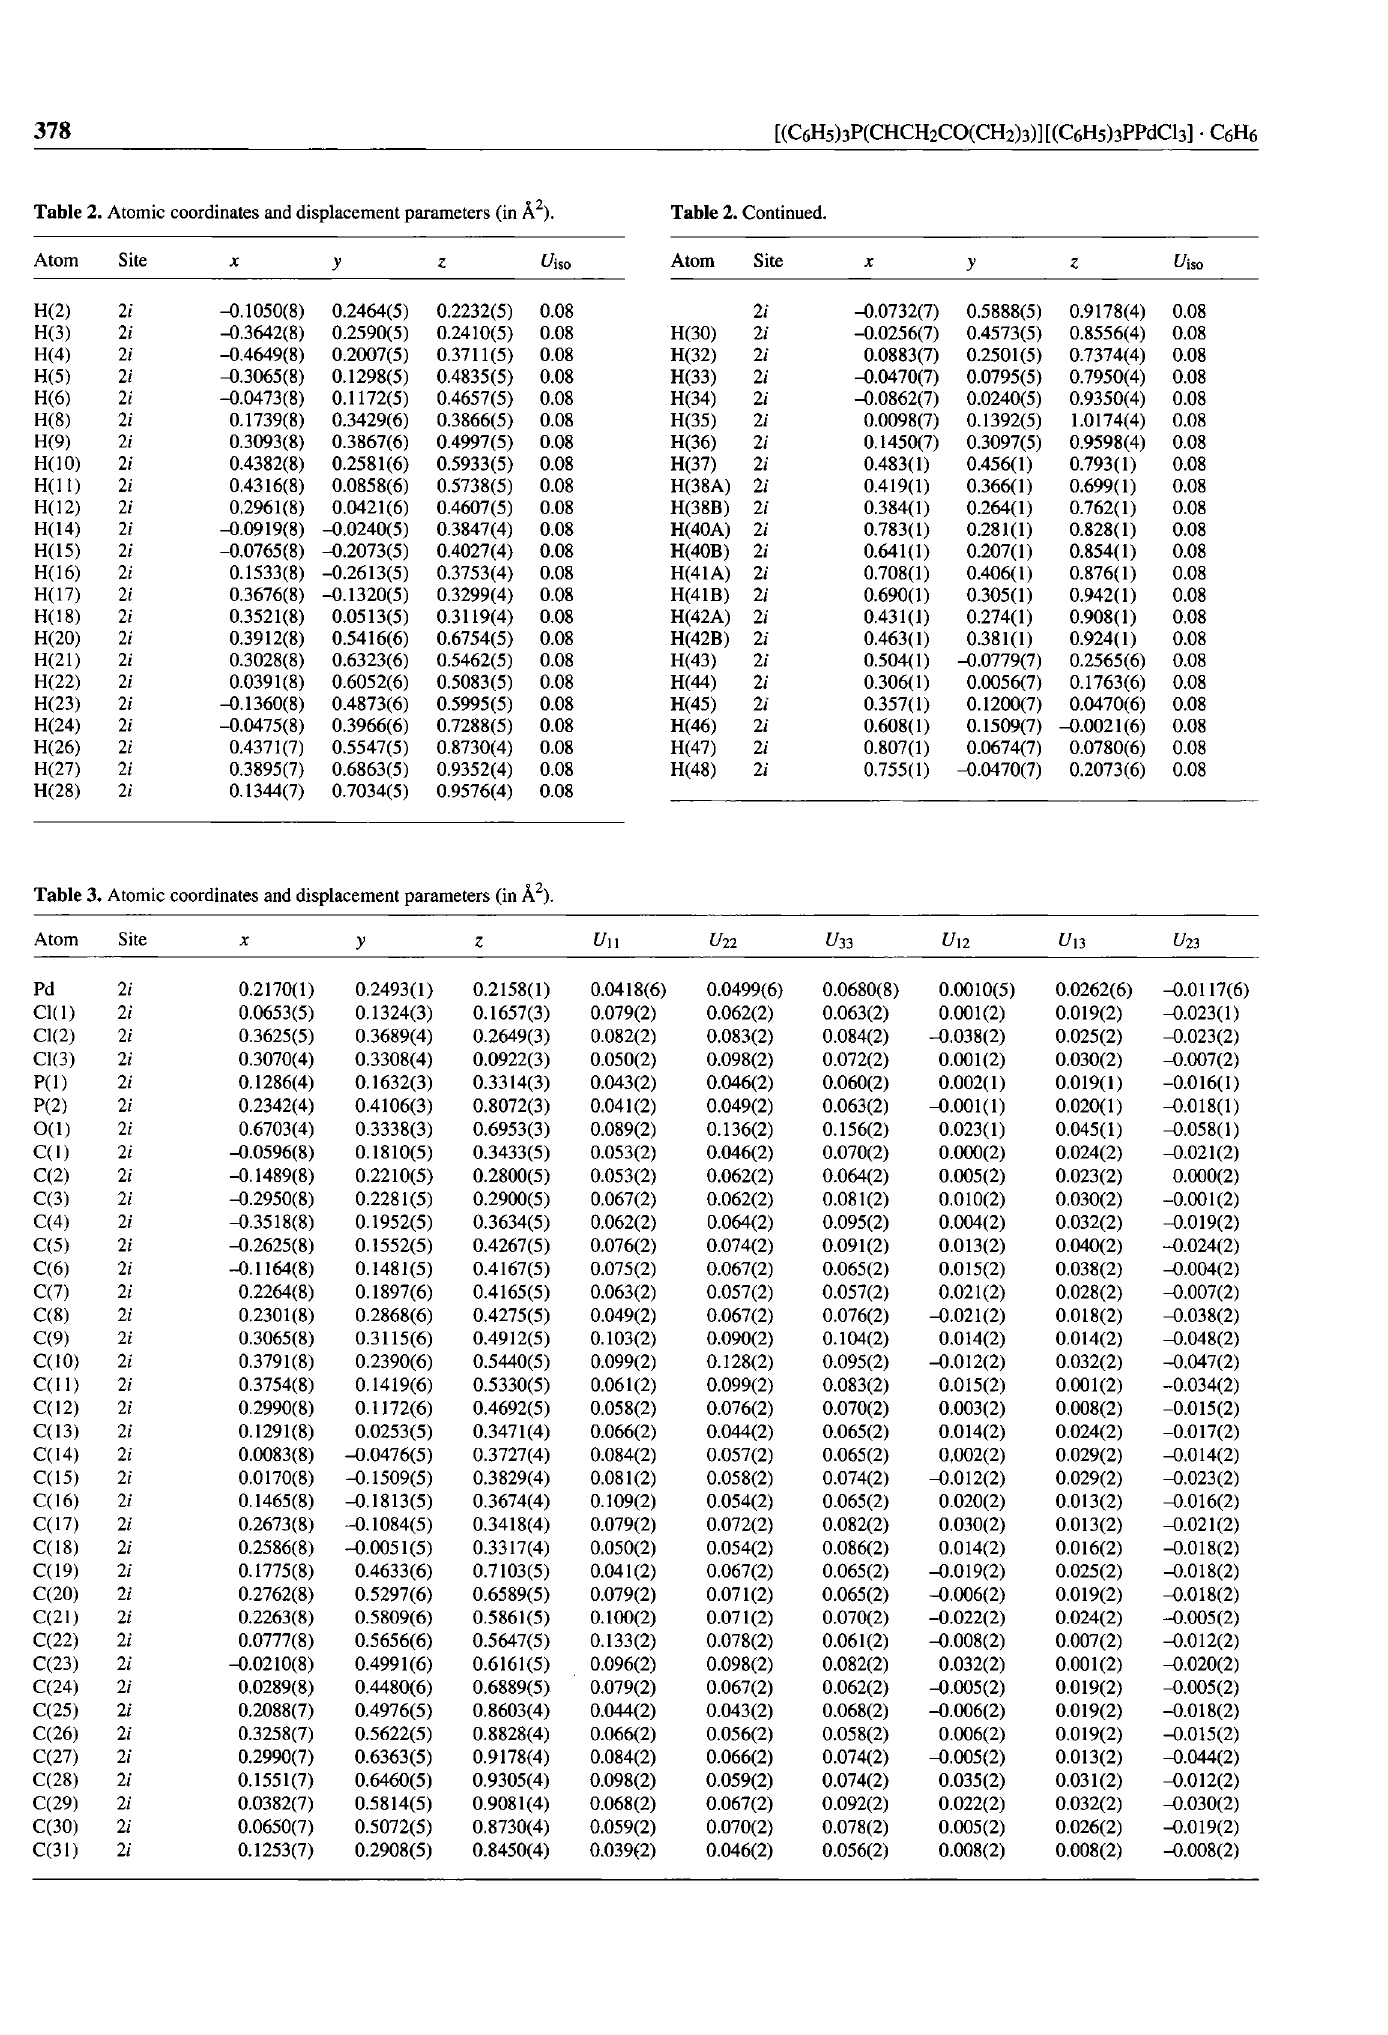
Table 3. Atomic coordinates and displacement parameters (in Ä 2